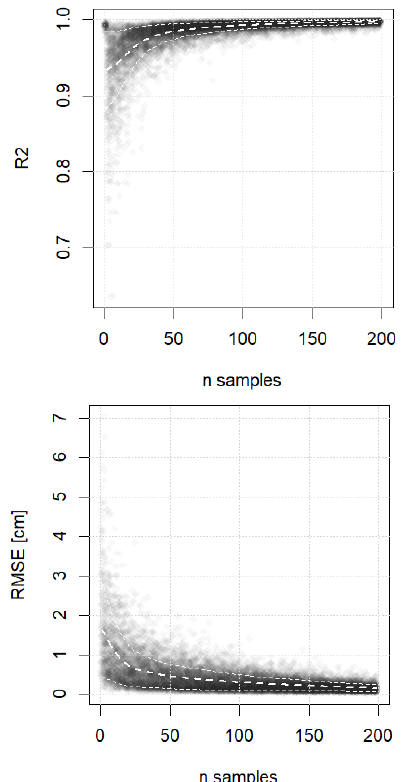
Fig. 8. The trade-off between sample size and accuracy for the estimation of stand-wise DBH distributions. The plots depict the accuracy in terms of r² (top) and RMSE (bottom) of the sample based DBH distribution compared to the DBH distribution of the simulated forest stands as derived by SILVA. The mean and standard deviation (white lines) were derived by smoothing